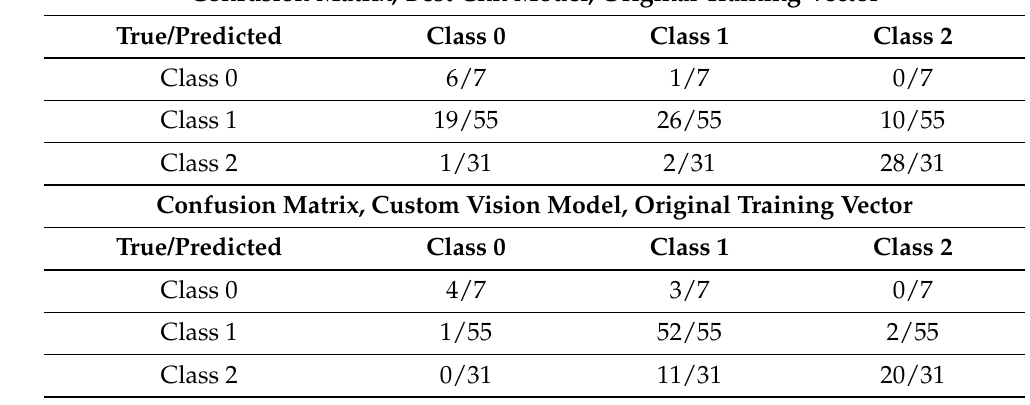
Table 26. Confusion matrices for best CNN Model and Custom Vision model corrected with original training vector on test set.